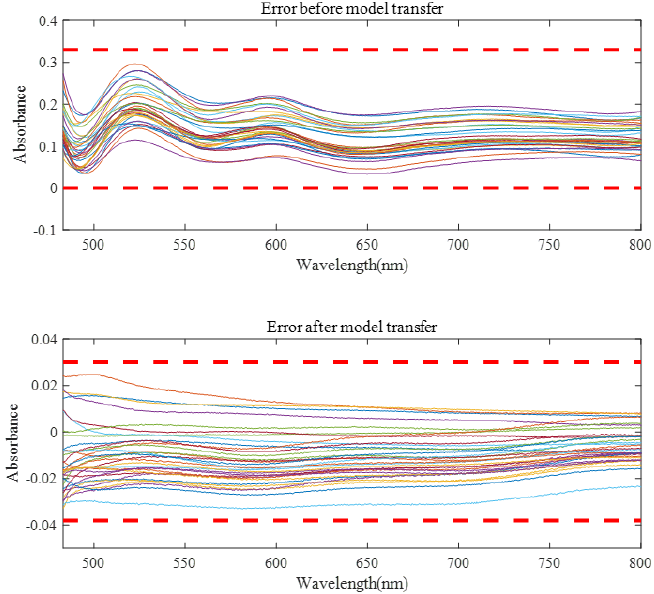
Figure 9. The spectral errors of the model were verified before and after spectral transfer.